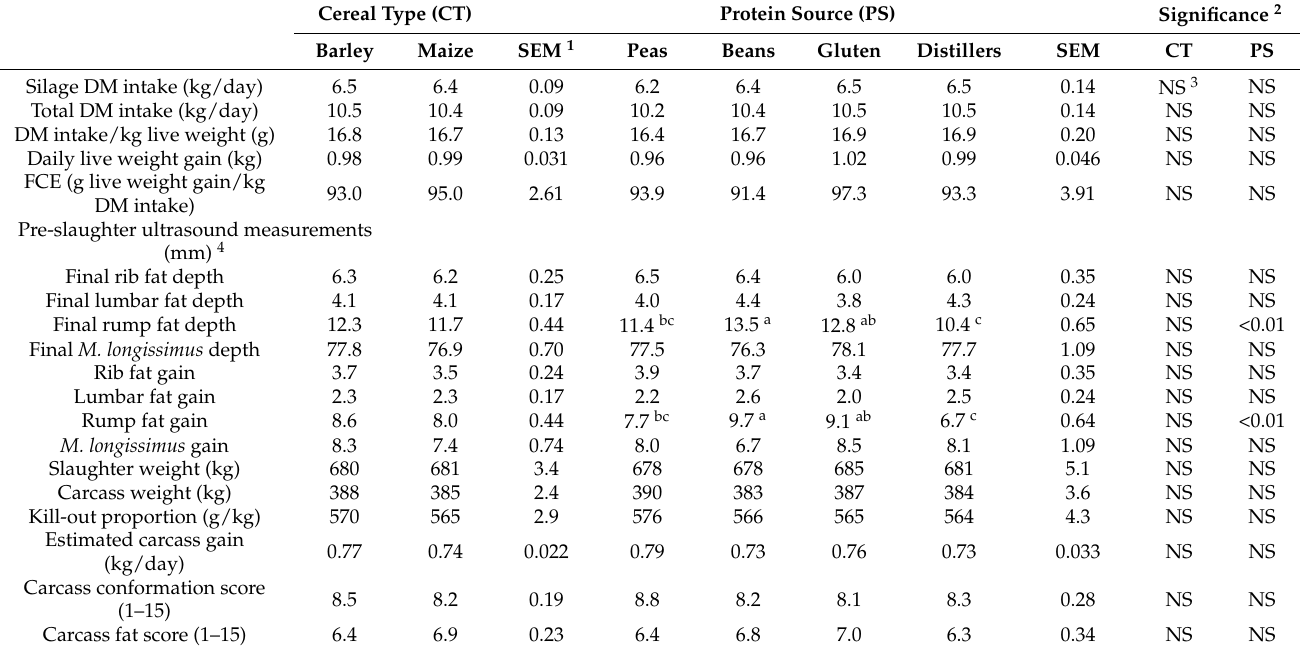
Table 5. Effects of cereal-based concentrate type and protein source on dry matter (DM) intake, growth, feed conversion efficiency (FCE), ultrasonic measures of body composition and carcass traits of steers in Experiment